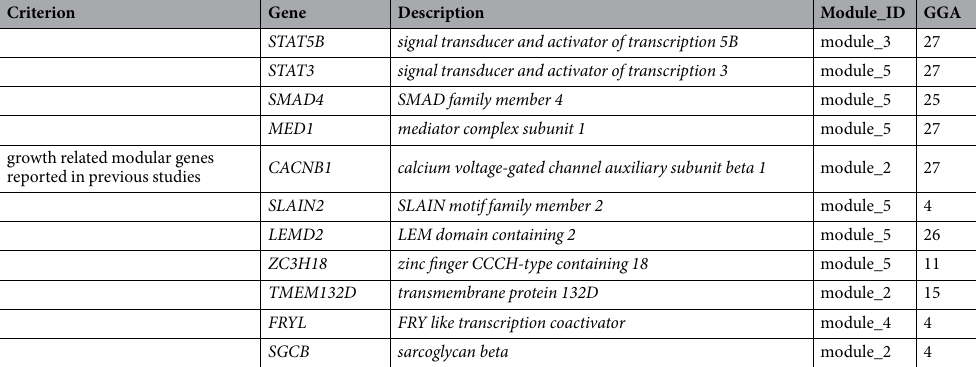
Table 3. List of 66 most plausible candidate genes for BW according to the following criteria: modular genes participating in enriched developmental processes, growth related modular genes not significantly enriched to any developmental process and growth related modular genes reported in previous